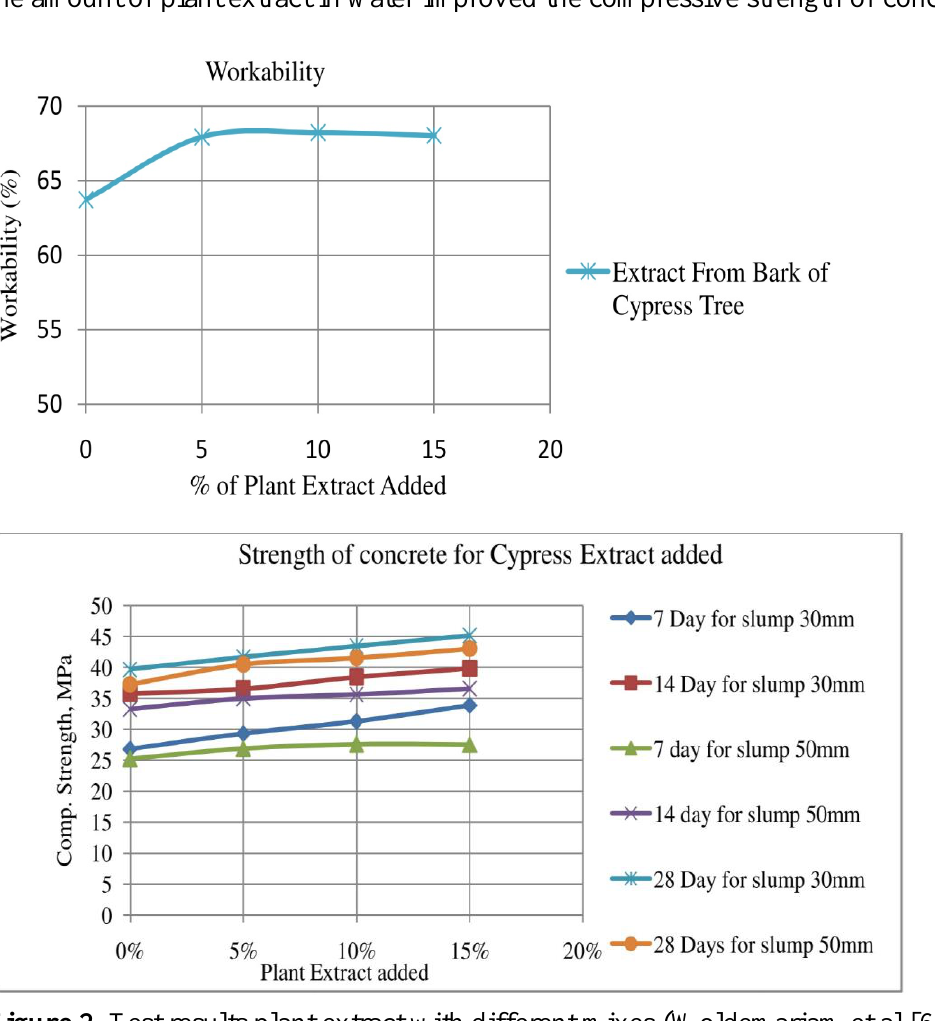
Figure 2. Test results plant extract with different mixes (Woldemariam et al [6]) Muhammed Shareef et al. [20] tested fresh and hardened properties of concrete containing 0, 1, 1.5, and 2% pulp black liquor (PBL), a waste material from the paper industry. Based on their data, 1.5% PBL is an optimum dosage to enhance slump, compressive strength, and splitting tensile strength. There was an increase in the concrete slump of about 5% as the maximum value. The 28-day compressive strength was found to increase from 25.04 MPa to 34.02 MPa for the M25 mix, while for the M30 mix, the strength